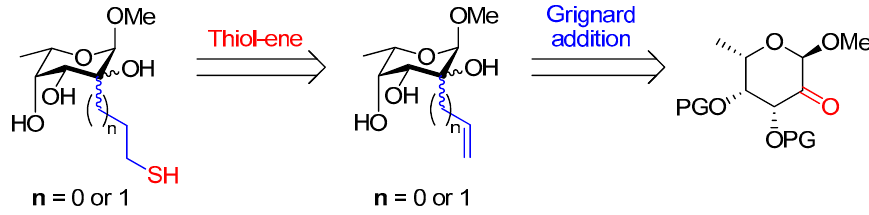
Figure 2. Target compounds 1 – 6 .